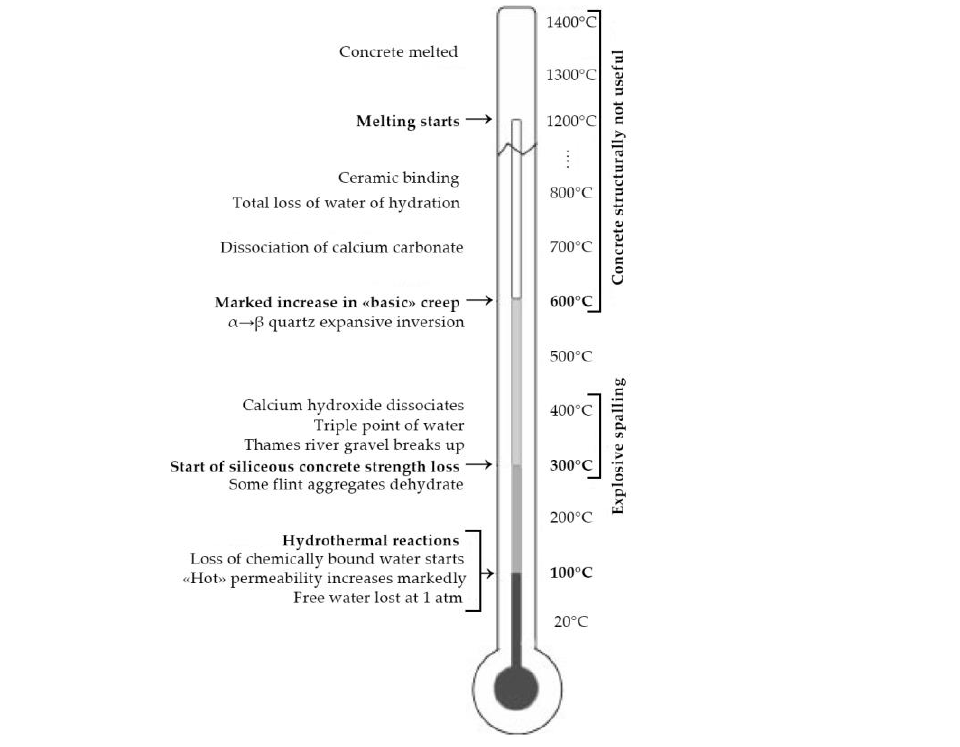
Figure 17. Physicochemical changes in concrete from ordinary Portland cement in heating process [63].